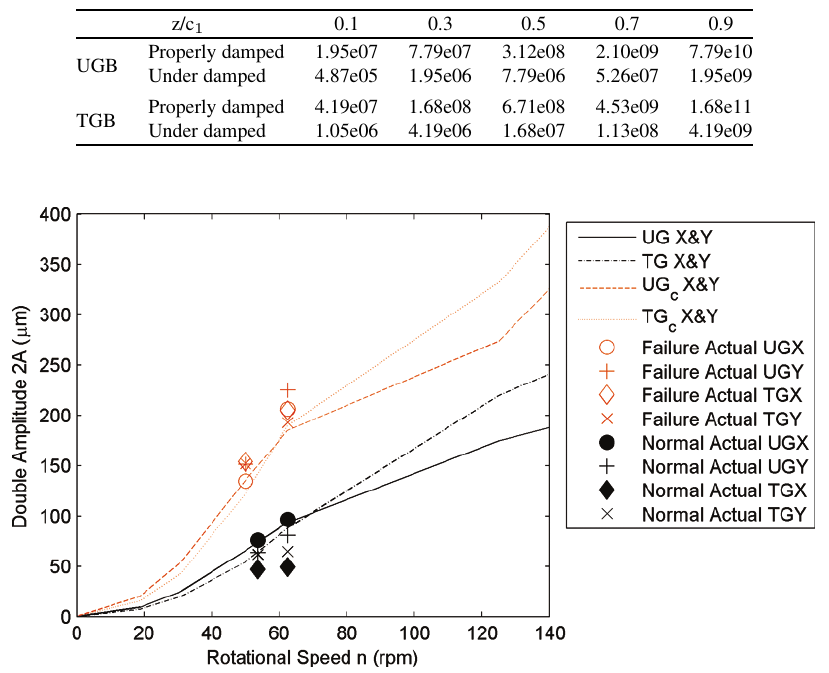
Fig. 10. Comparison of simulation results for specified bearing mounting clearance (UG and TG) and enlarged bearing mounting clearance (UG and TG enlarged). Markers show the actual readings from field